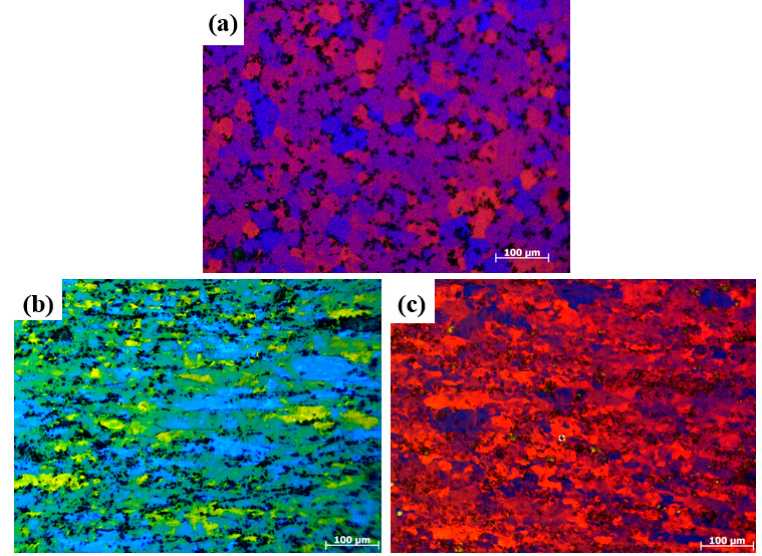
Figure 6. Polarized light optical micrograph of Al-TiB 2 /TiC in situ composites: ( a ) As cast; ( b ) Rolled for 90% reduction; ( c ) After one ARB cycle.